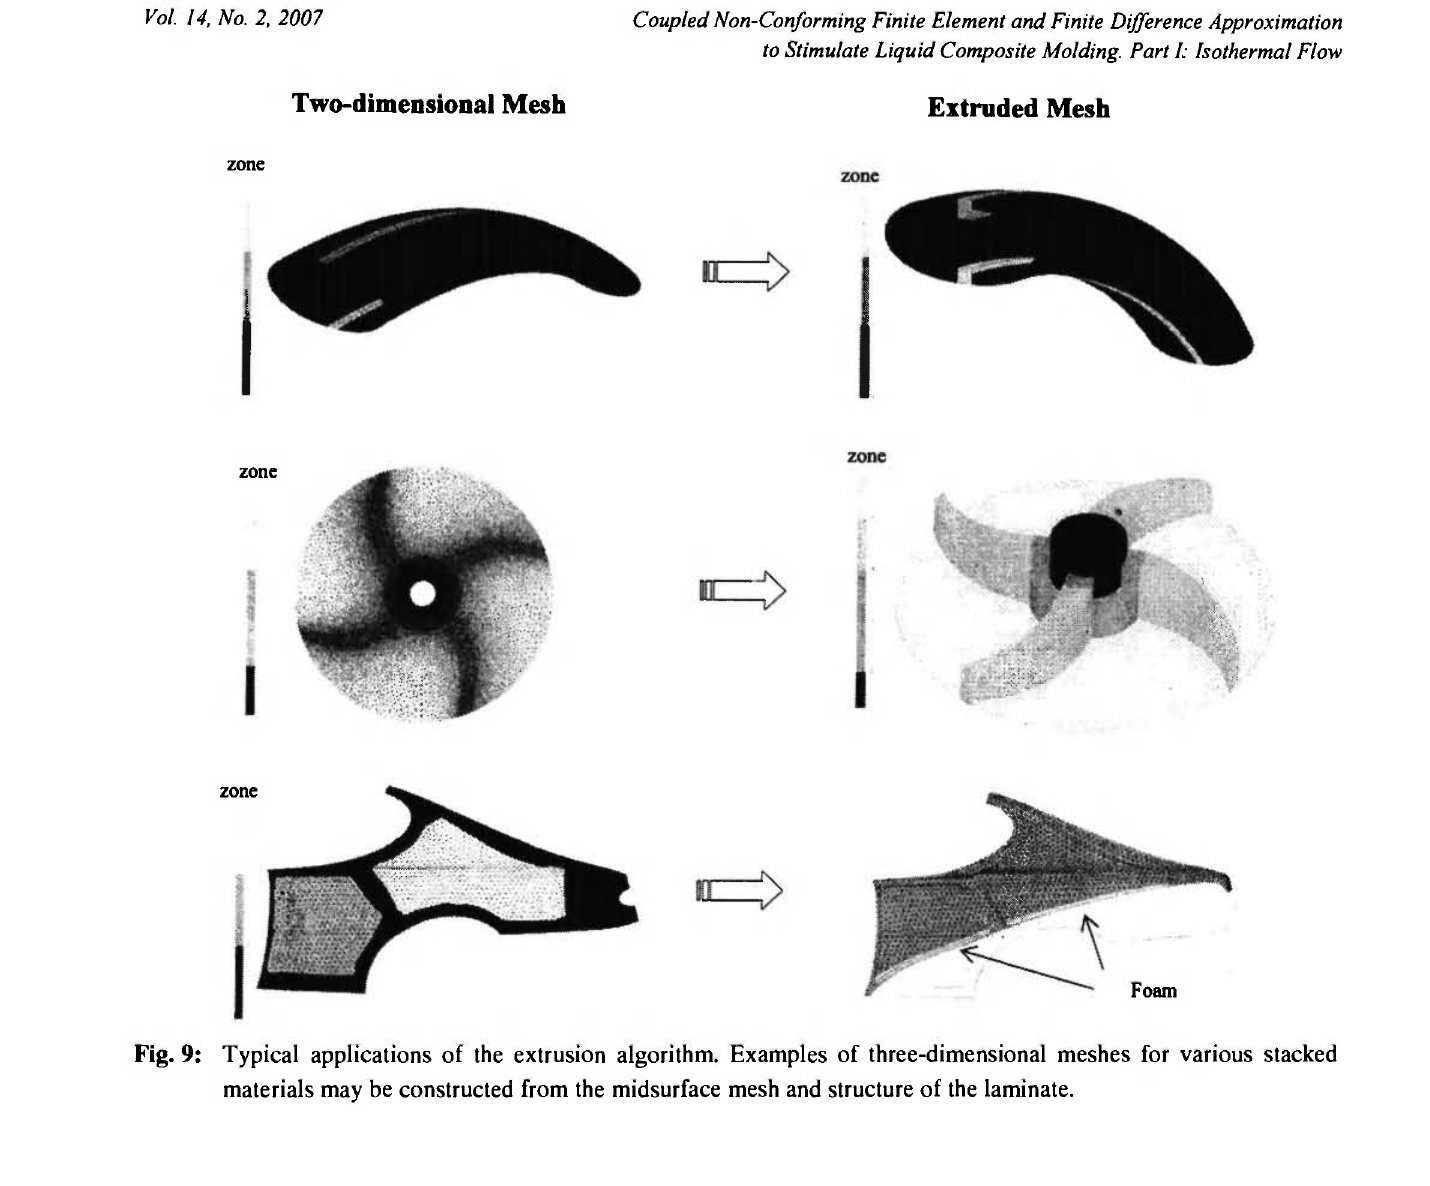
Fig. 9: Typical applications of the extrusion algorithm. Examples of three-dimensional meshes for various